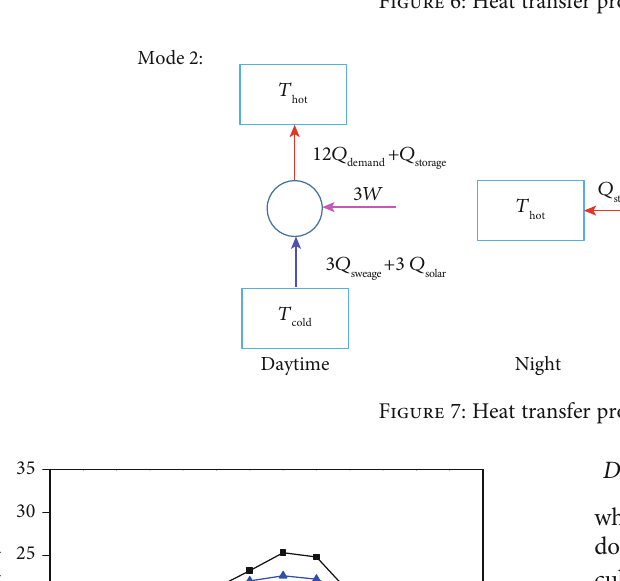
Figure 6: Heat transfer process of mode 1.